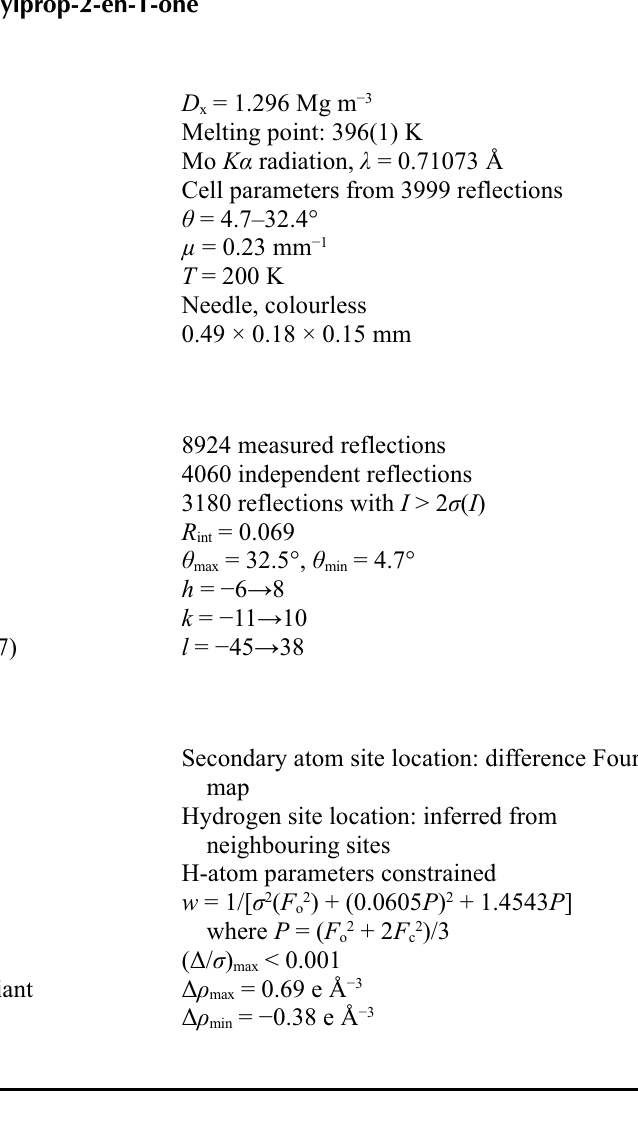
The molecular structure of the title compound, showing the atom-numbering scheme and displacement ellipsoids drawn at the 50% probability level. Hydrogen atoms are represented by spheres of arbitrary